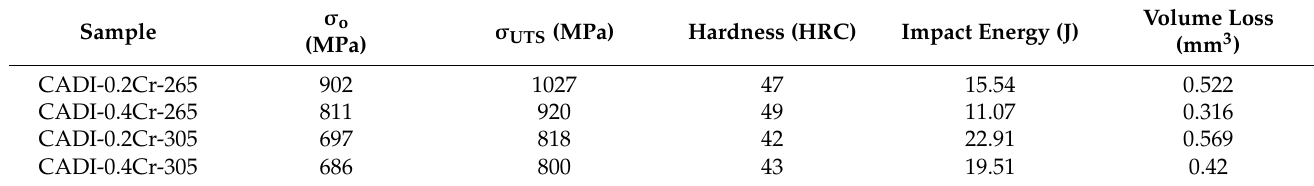
Table 5. Mechanical properties of the CADIs